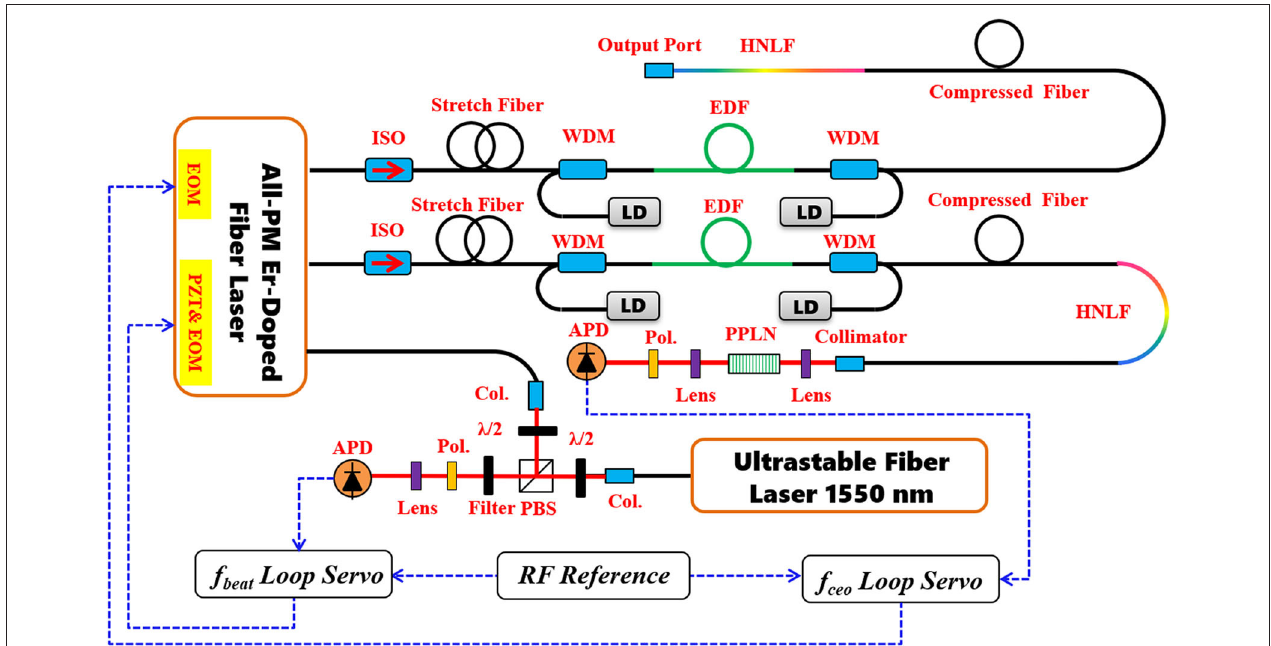
FIGURE 1 | Experimental set-up of wavelength-tunable ultra-stable